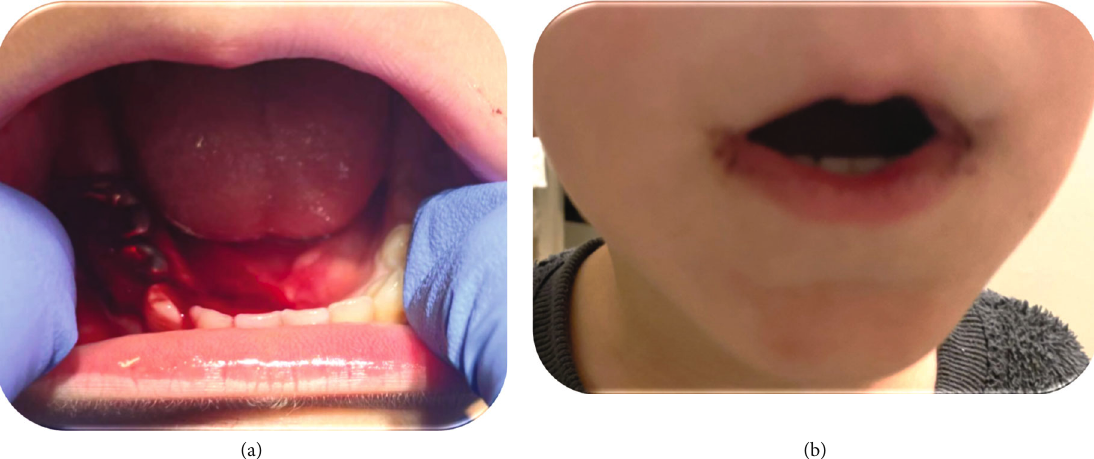
Figure 4: Patient case 6. (a) Excessive bleeding and a blood clot, 4 days after placing 2 SSCs and following receiving IV anti fi brinolytic tranexamic acid and biting on an oral pack soaked with solution of anti fi brinolytic tranexamic acid. (b) Three and four days after placing 2 SSCs that were pre-soaked in water for 5 weeks before use. Small blood clots were visible, only in the morning, at the corner of the child ’ s